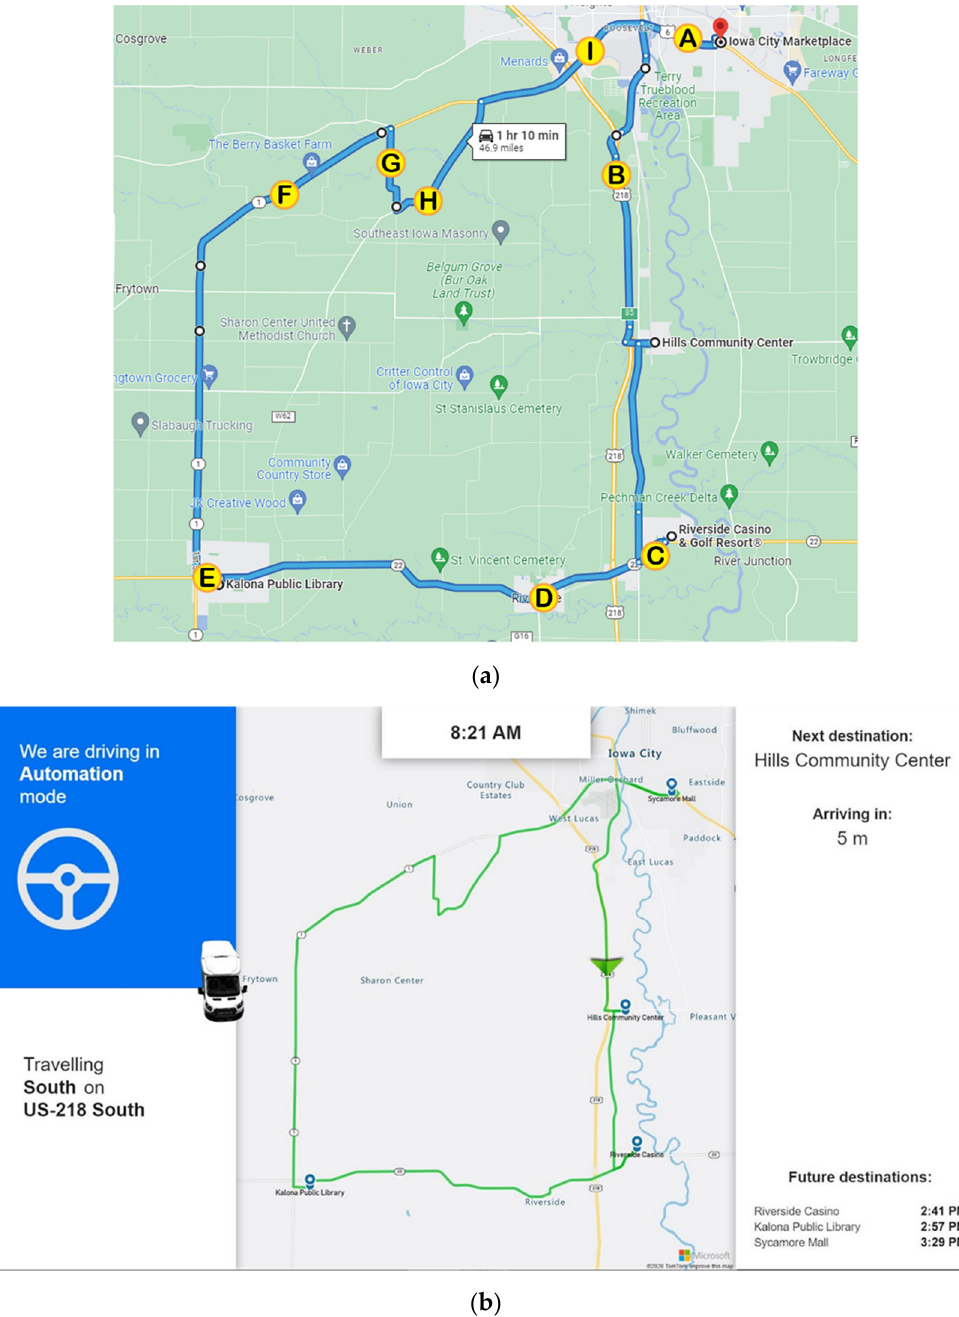
Figure 2. ( a ) Map indicating rating locations of anxiety; ( b ) Interactive map that was provided to the participant during their shuttle ride.